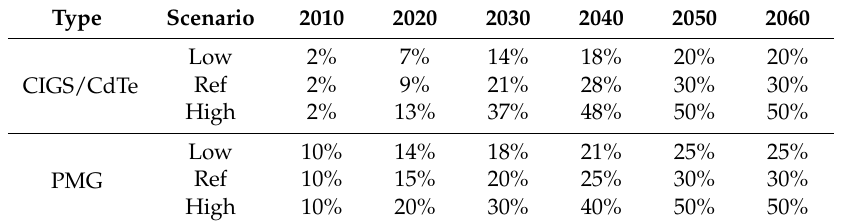
Table 3. Share of CIGS/CdTe type photovoltaic (PV) panels within the PV market and Permanent Magnet type Generator (PMG) type wind power generator within the wind power market